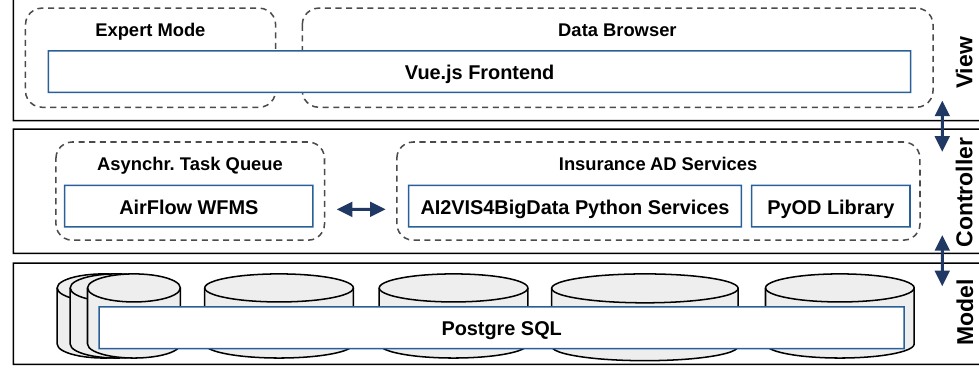
Figure 13. Solution architecture with applied technologies.